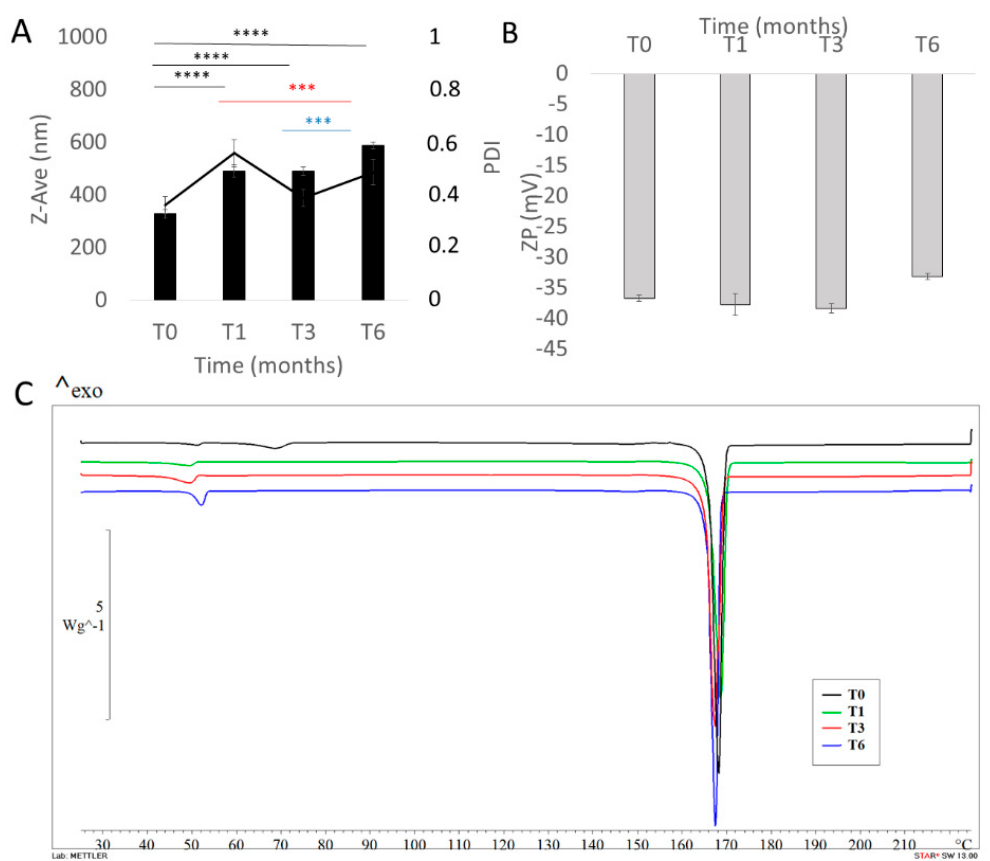
Figure 6. Stability study of lyophilized NCs stored at room temperature and analyzed by photon correlation spectroscopy (PCS): A) mean size and PDI: B) zeta potential (ZP) and C) DSC analysis up to 6 months. Tukey’s test for NC size and ZP. The black * symbol indicates statistical significance difference vs. T0 group; The red * symbol indicates statistical significance difference vs. T1 group; The blue * symbol indicates statistical significance difference vs. T3 group. Significance was defined as *** p < 0.001 **** p < 0.0001.